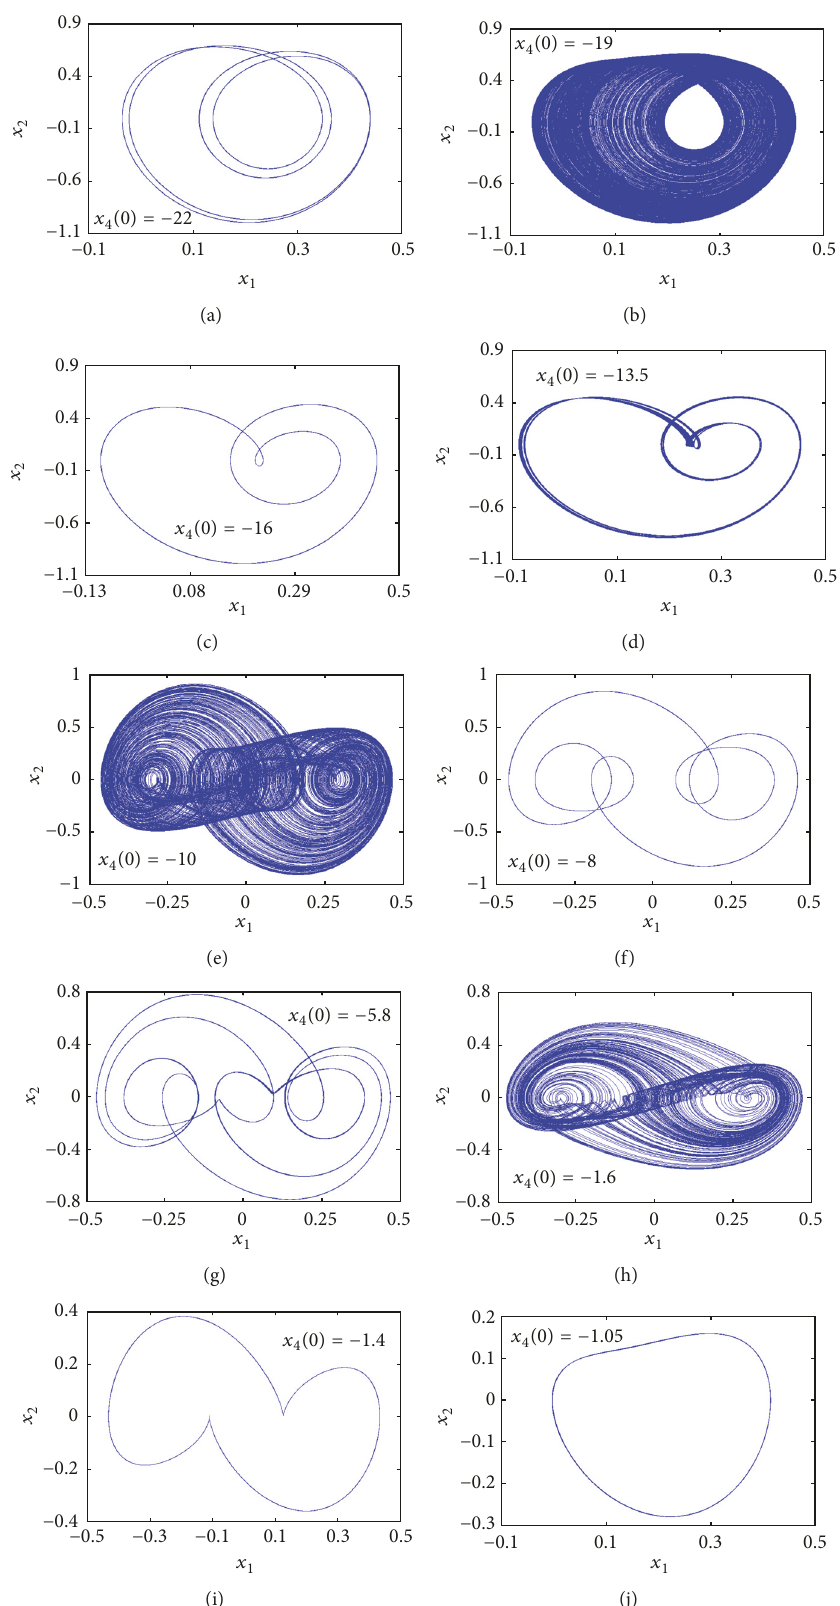
Figure 5: Phase portraits of typical coexisting attractors with different memristor initial conditions, where x 1 (0) = 0, x 2 (0) = 0.1, and x 3 (0) = 0. (a) x 4 (0) = − 22. (b) x 4 (0) = − 19. (c) x 4 (0) = − 16. (d) x 4 (0) = − 13.5. (e) x 4 (0) = − 10. (f) x 4 (0) = − 8. (g) x 4 (0) = − 5.8. (h) x 4 (0) = − 1.6. (i) x 4 (0) = − 1.4. (j) x 4 (0) = −